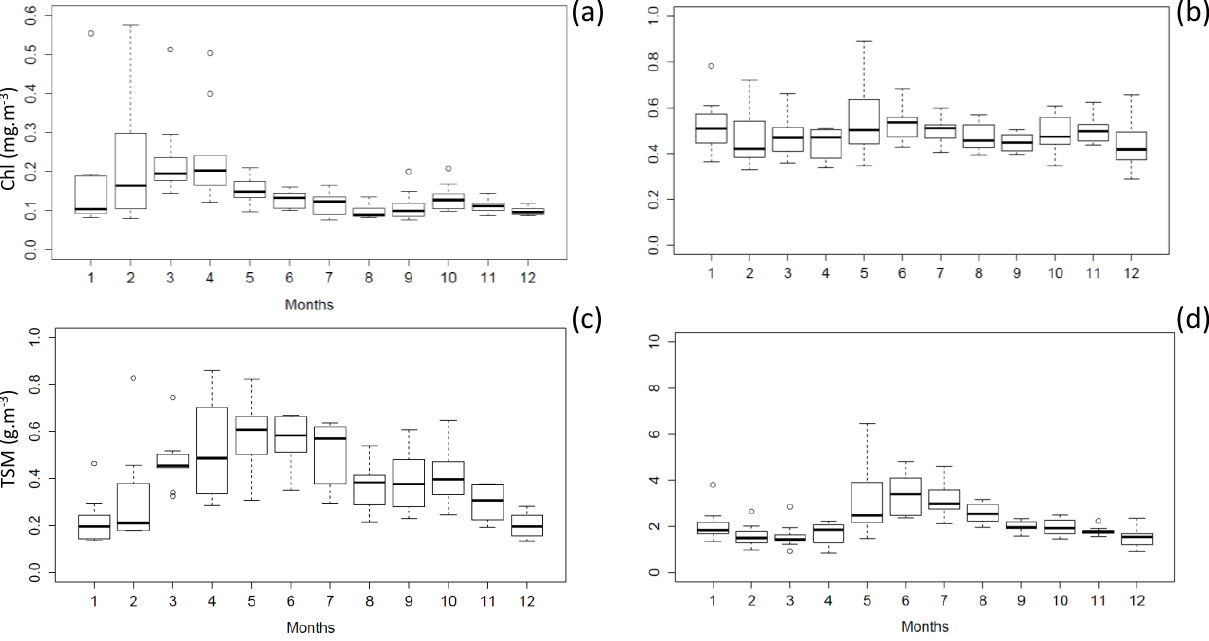
Figure 6. Boxplots of monthly Chl and TSM for the GBRW ( a , c ) and VDG ( b , d ) clusters based on the MERIS 10-year dataset. The boundary of the box indicates the 25th and 75th percentiles, the line within the box indicates the median, the whiskers above and below the box indicate the 90th and 10th percentiles, and the dots outside the box are outlying